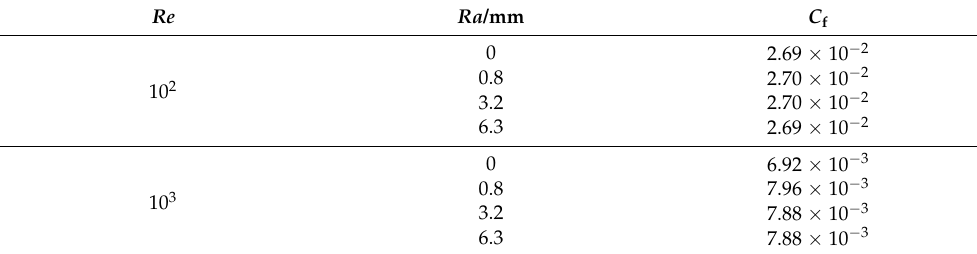
(smooth wall) to 6.3 μ m.